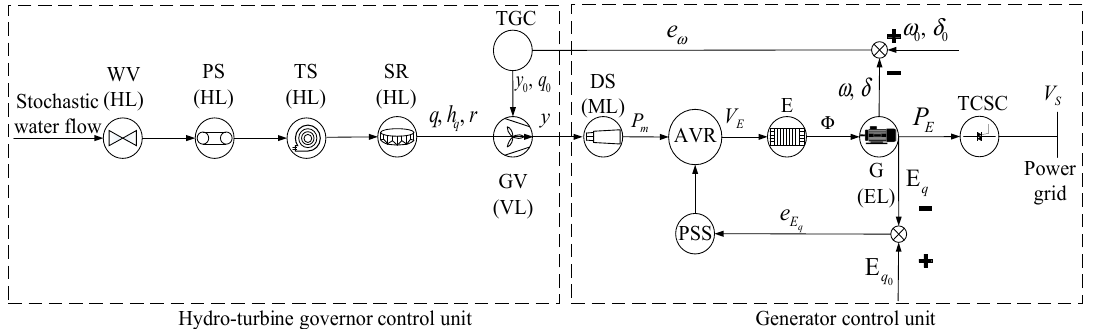
Figure 2. The component diagram of a HS.